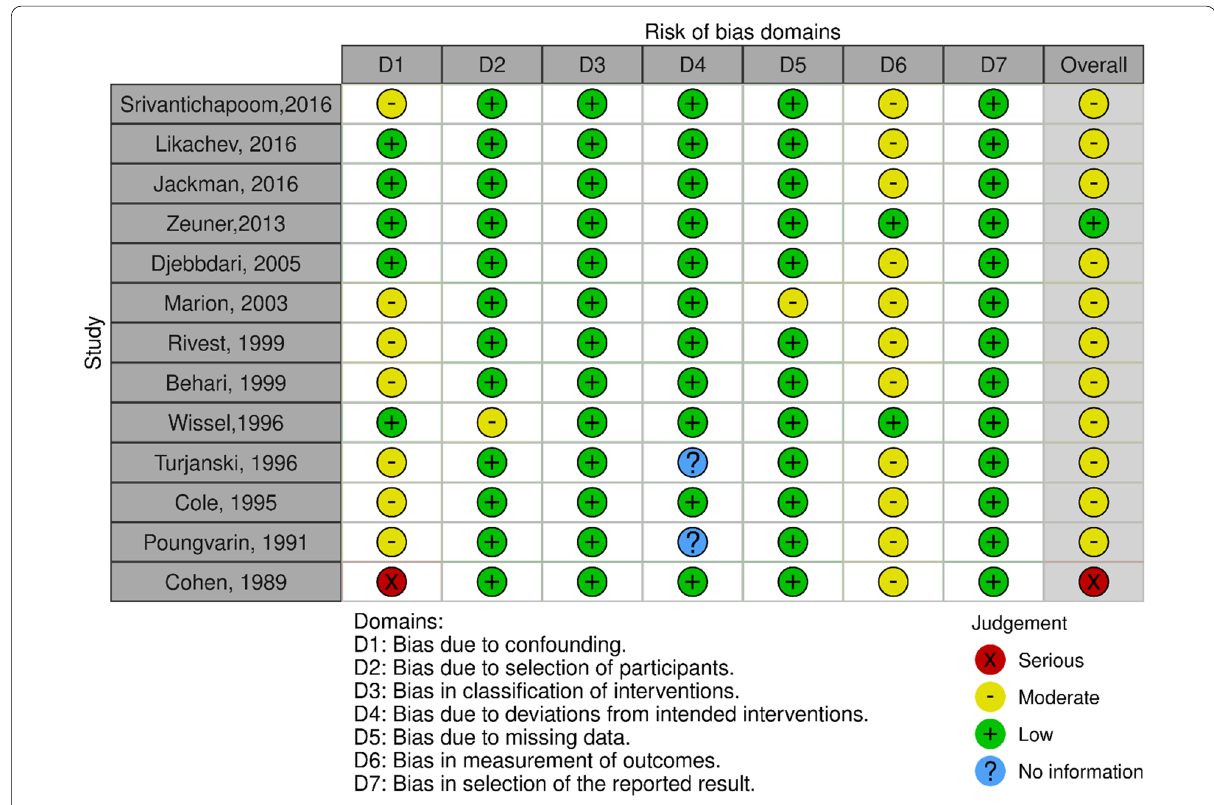
Fig. 2 Risk of bias assessment for observational studies using ROBINS-I